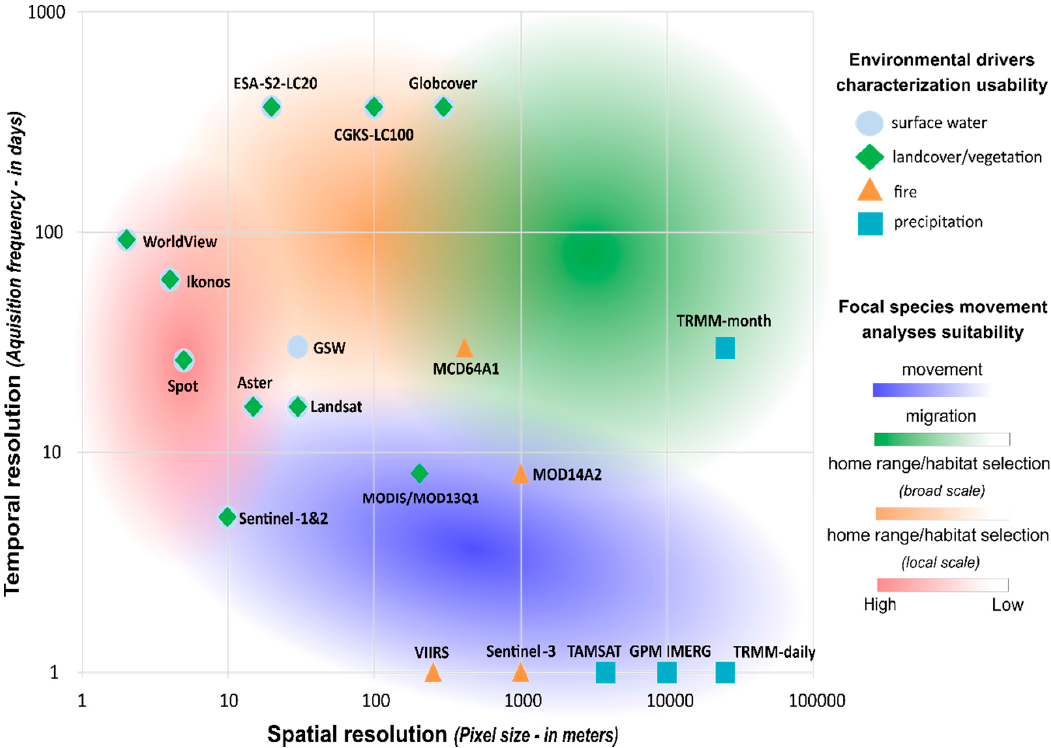
Figure 5. Suitable SRS products for ecologists to characterize environmental drivers impacting animal movements in semi-arid savannas landscapes. These SRS products are represented according to their temporal (ordinate axis) and spatial resolution scales (abscissa axis) and can be used for di ff erent type of analyses related to animal movements (movement patterns, home-range and habitat selection at broad and local scales, migration) [59]. We define the “movement” (represented in blue) as the motion initiated by a variety of methods that focal species use to move from one place to another. The “migration” (represented in green) is defined as long distance movements to a di ff erent environment involving periodical and cyclical dynamics in space and time. Home range and habitat selection (represented in orange at broad scale and in red at local scale) are considered as areas where focal species regularly move depending on natural resource selections and social interactions and behaviors. Note that the contours of the di ff erent analyses categories are blurred to emphazise the fact that there are no clearly established boundaries between these categories.